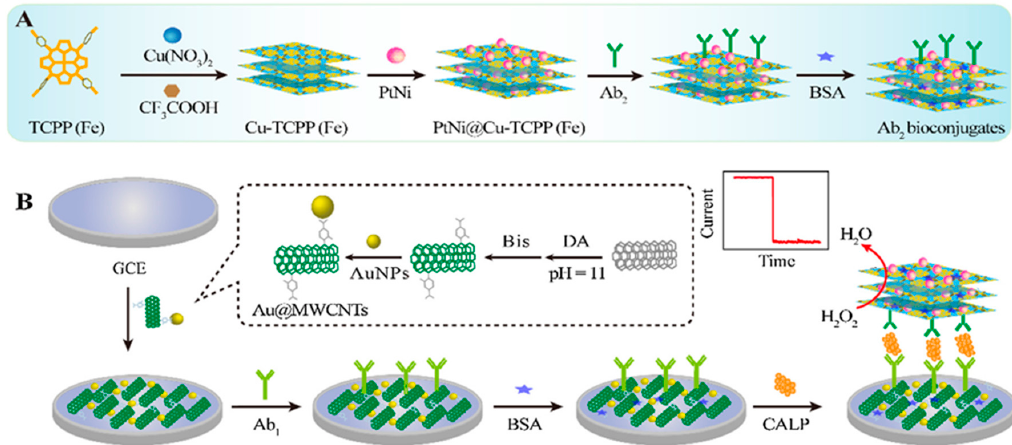
Figure 4. Schemes of ( A ) the preparation procedure of PtNi@Cu-TCPP(Fe)-Ab 2 bioconjugates and ( B ) the construction process of the electrochemical immunosensor for calprotectin (CALP). Reproduced from [12] with permission.